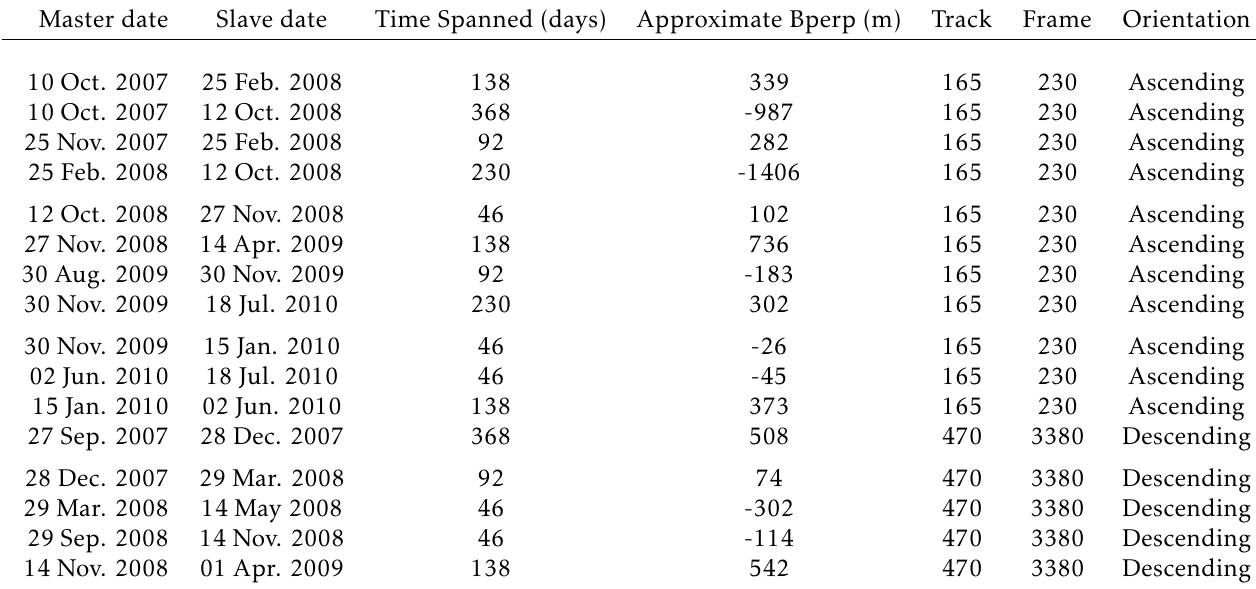
Table A2 – InSAR acquistions for Masaya volcano,